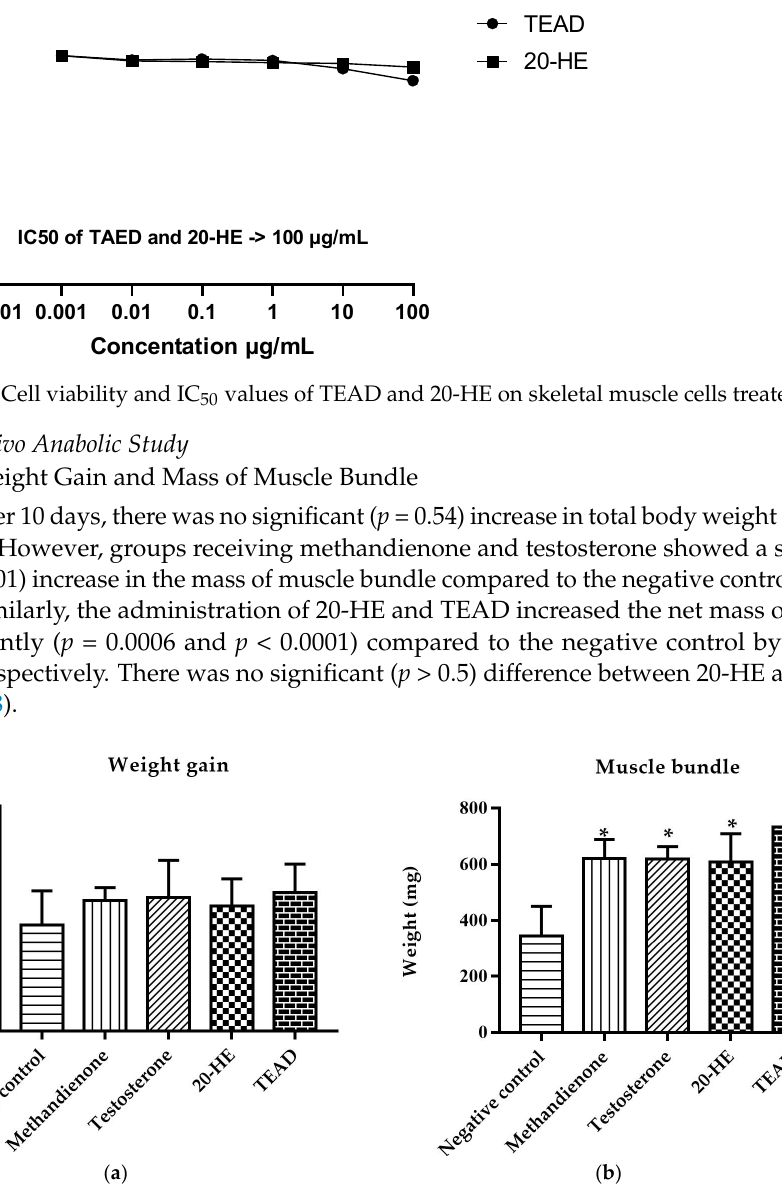
Figure 6. Clashing of 20-HE in the binding sites of ER α ( a ) and AR ( b ). Dashed lines in orange indi- cate unfavorable distances, while those in red indicate disallowed distances. 2.6. Evaluation of the Cytotoxic Activity of 20-HE and TEAD (SRB-U Assay)